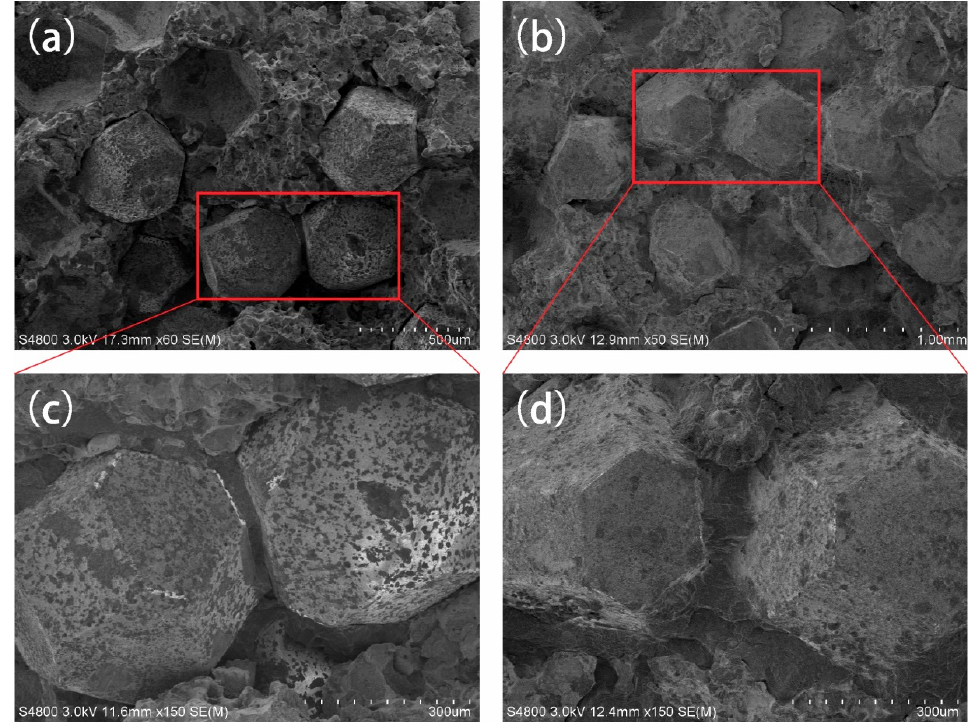
Figure 4. Microstructure of diamond on fracture surface of samples F0 ( a , c ) and F4 ( b , d ).